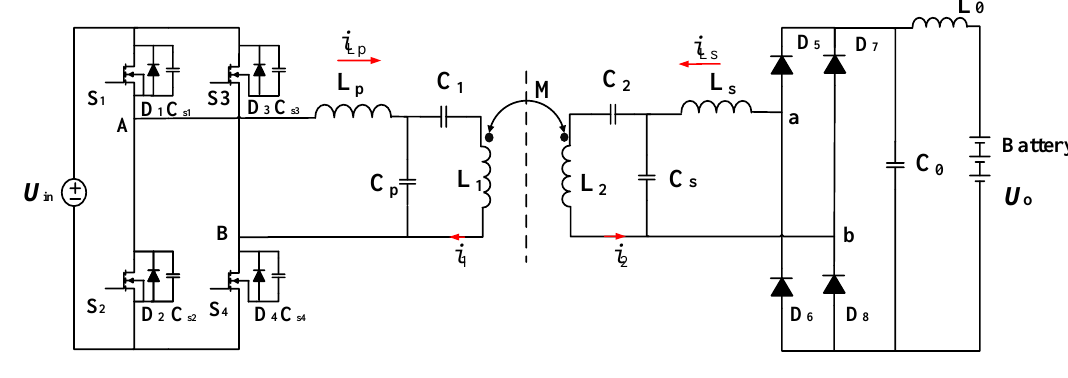
Figure 1. Schematic of double-sided LCC resonant compensation network.